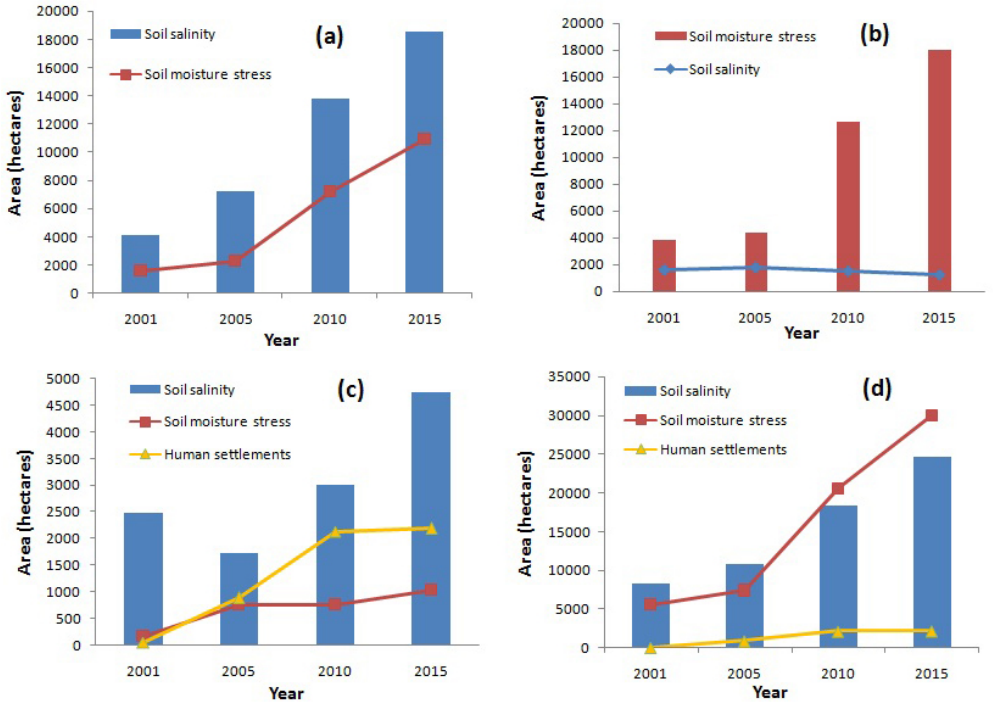
Figure 7. (a) Areal extent of soil moisture and soil salinity for drought-affected zone from 2001 to 2015, in which the growth of saline- affected regions is in high proportion compared to the moisture-affected regions due to native fluoride content and clayey soil origin. (b) Areal extent of soil moisture and salinity in wind-affected zone from 2001 to 2015. The soil moisture stress has been accelerated in the wind-affected zone, rather than the salinity. (c) Soil salinity, moisture stress and human occupancy are together observed in the human-affected region from 2001 to 2015. Human settlements are elevated at a higher rate, followed by man-made salinity and soil moisture stress. (d) The overall rate of soil degradation processes at the study region irrespective of the causative